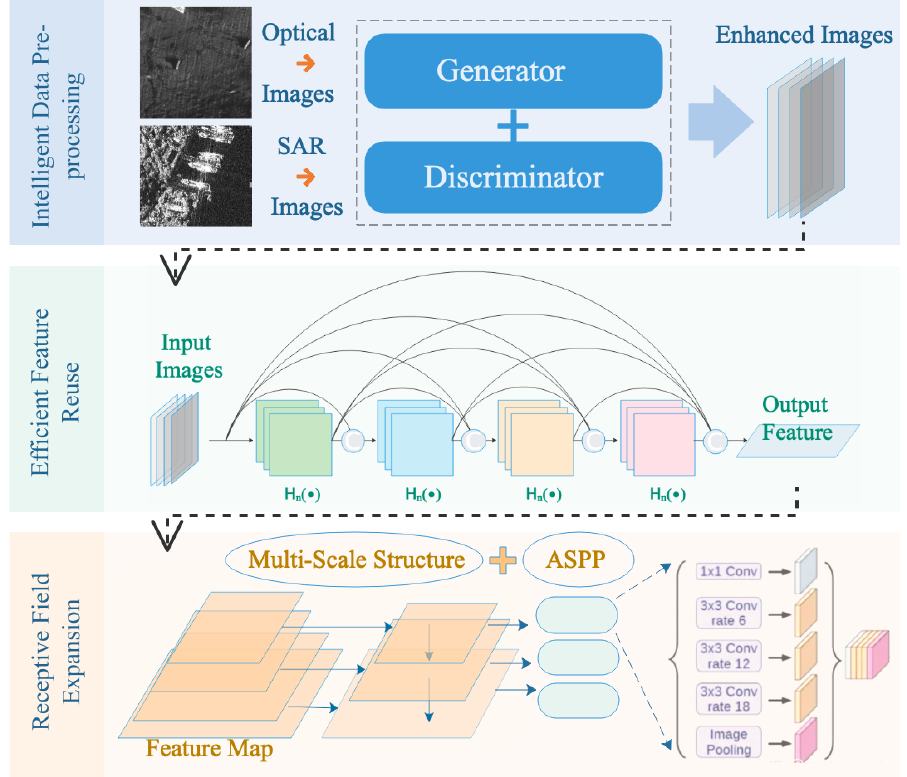
Figure 1. Framework of the proposed algorithm for ship target detection in remote sensing im- agery